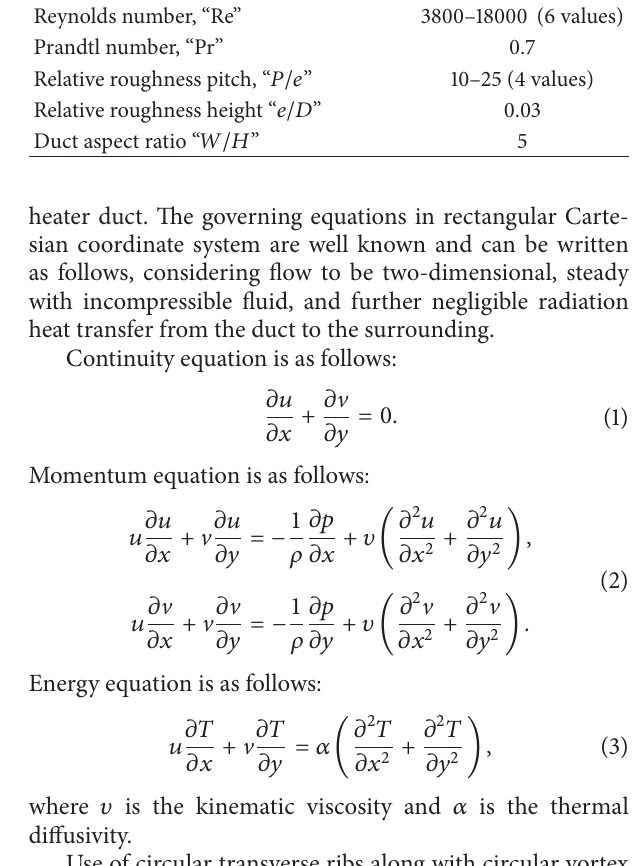
Figure 3: Two-dimensional nonuniform grid.